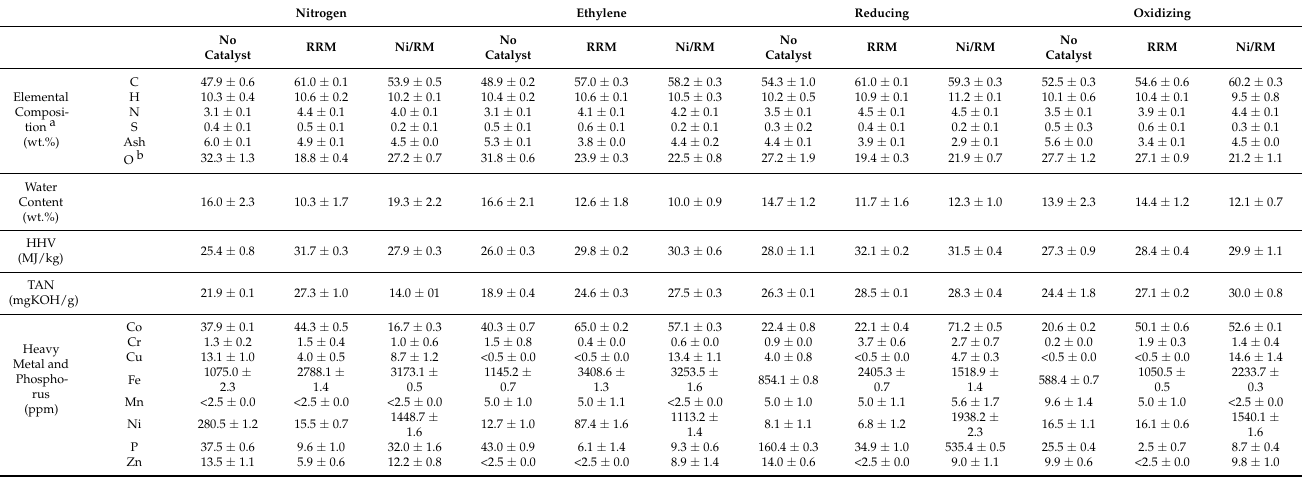
Table 2. Physicochemical properties of Tetraselmis HTL